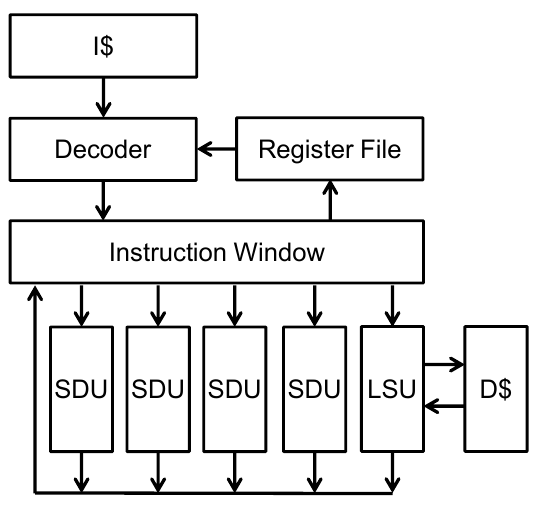
Figure 1. Superscalar processor